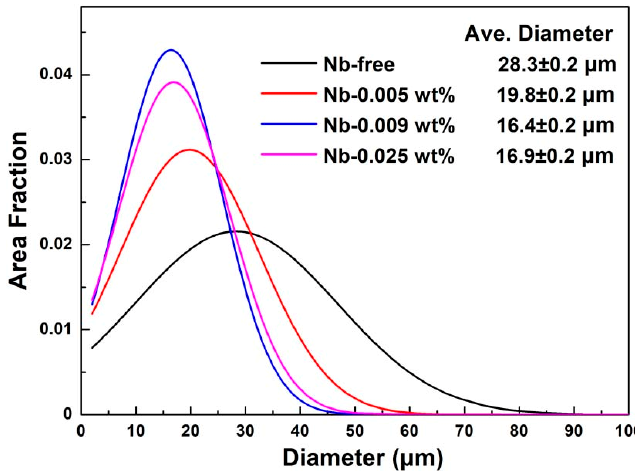
Figure 5. Grain diameter distribution after primary annealing.